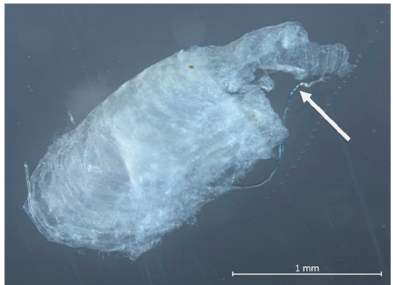
Figure 6. Hydroptilidae caddisfly case with a white fiber of plastic indicated by the white arrow. Photo by Dr. Silvio Kroha; Microscope ZEISS Axio Zoom.V16 connected to an Axiocam 503 (Stereo Zoom Microscope).